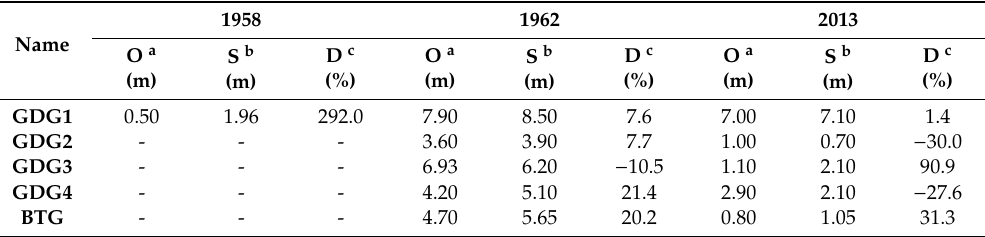
Table 9. Observed versus simulated residual deposition height ( ∆